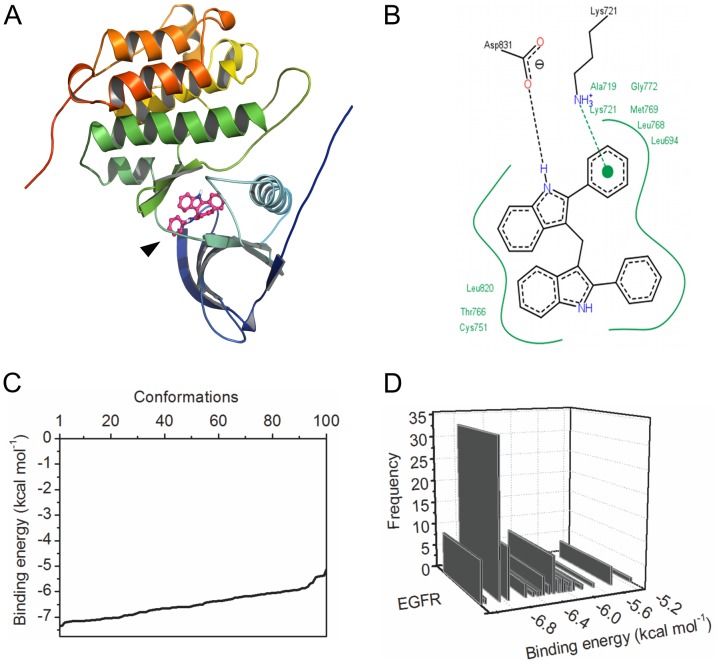
Binding analysis of DPDIM with EGFR.(A), Ribbon representation of human EGFR kinase domain docked with DPDIM into its ATP binding site. Arrow shows the binding of DPDIM to the receptor. (B), Two-dimensional representation of DPDIM-EGFR binding interactions. Green solid lines represents hydrophobic interactions, π-cation interaction is shown in green dotted line and the hydrogen bonding with black dotted line. Residues were numbered according to the PDB ID 1M17. (C) and (D) display the thermodynamic analysis of statistical ensemble of the ligand/receptor complex. (C), Energy spectrum distribution of system states (observed conformations) as determined by molecular docking computation and (D), concordant cluster distribution of the ensemble structures over the energy axis. Conformations within 2 Å root mean square deviation (irrespective of their binding energy) were clustered together. The graphs were plotted with OriginPro 8.